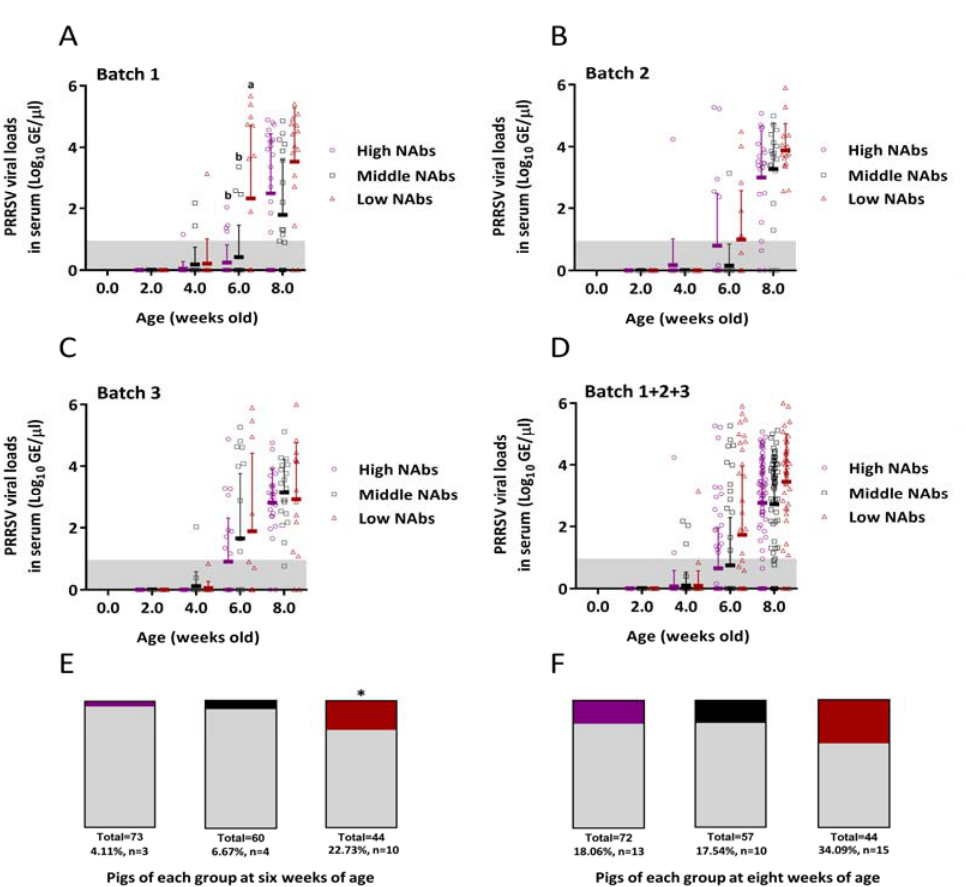
Figure 5. PRRSV viral loads in serum as detected by RT-qPCR ( A – D ). The mean values of PRRSV genomic equivalents (GE) were transformed into log 10 GE/ µ L. The error bars indicate standard deviations. The limit of detection for RT-qPCR was 0.96 log 10 GE/ µ L marked as the gray zone. PRRSV viral loads in the low, middle and high NAbs groups at six weeks of age in batch 1 were as follows, 2.32 ± 1.66, 0.42 ± 0.72 and 0.24 ± 0.32 log 10 GE/ µ L, respectively. Statistically significant differences were present between a and b ( p < 0.05). Numbers (and percentages) of pigs in the high (purple area), middle (black area) and low (red area) NAbs groups whose viral loads in serum exceeded 4.2 log 10 GE/ µ L are shown in the stacked bar graphs ( E , F ). The gray areas of the bar graphs represent the remaining pigs whose serum viral loads were below 4.2 log 10 GE/ µ L in each group. * indicates significant differences ( p <